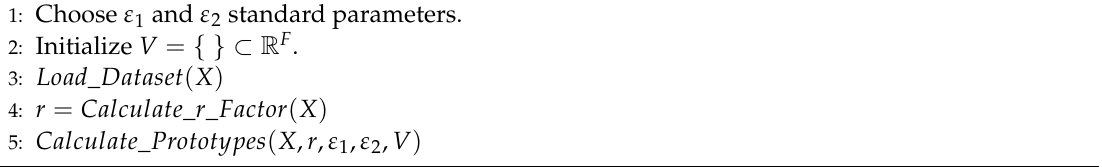
Algorithm 2 The FM algorithm, where X is the input dataset to be classified, V is the algorithm output that contains the prototypes found by the clustering process. F is the dimension of the vector space.